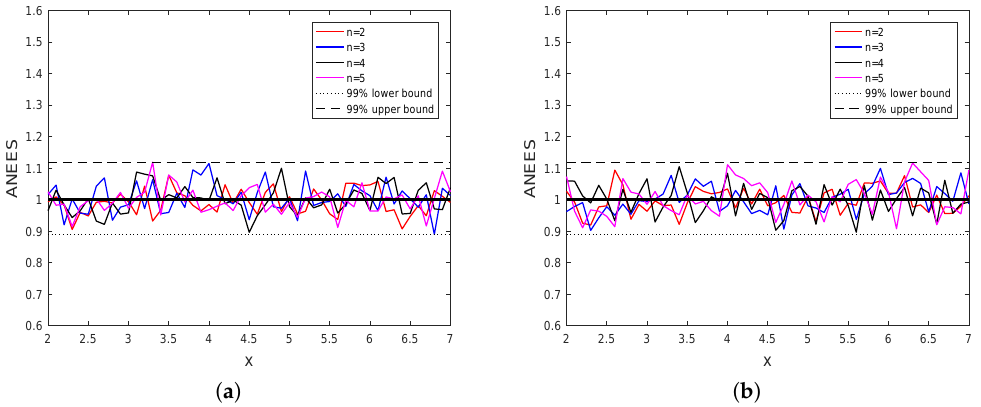
Figure 6. ( a ) ANEES vs. x using 10 scalar measurements and ( b ) ANEES vs. x using 20 scalar